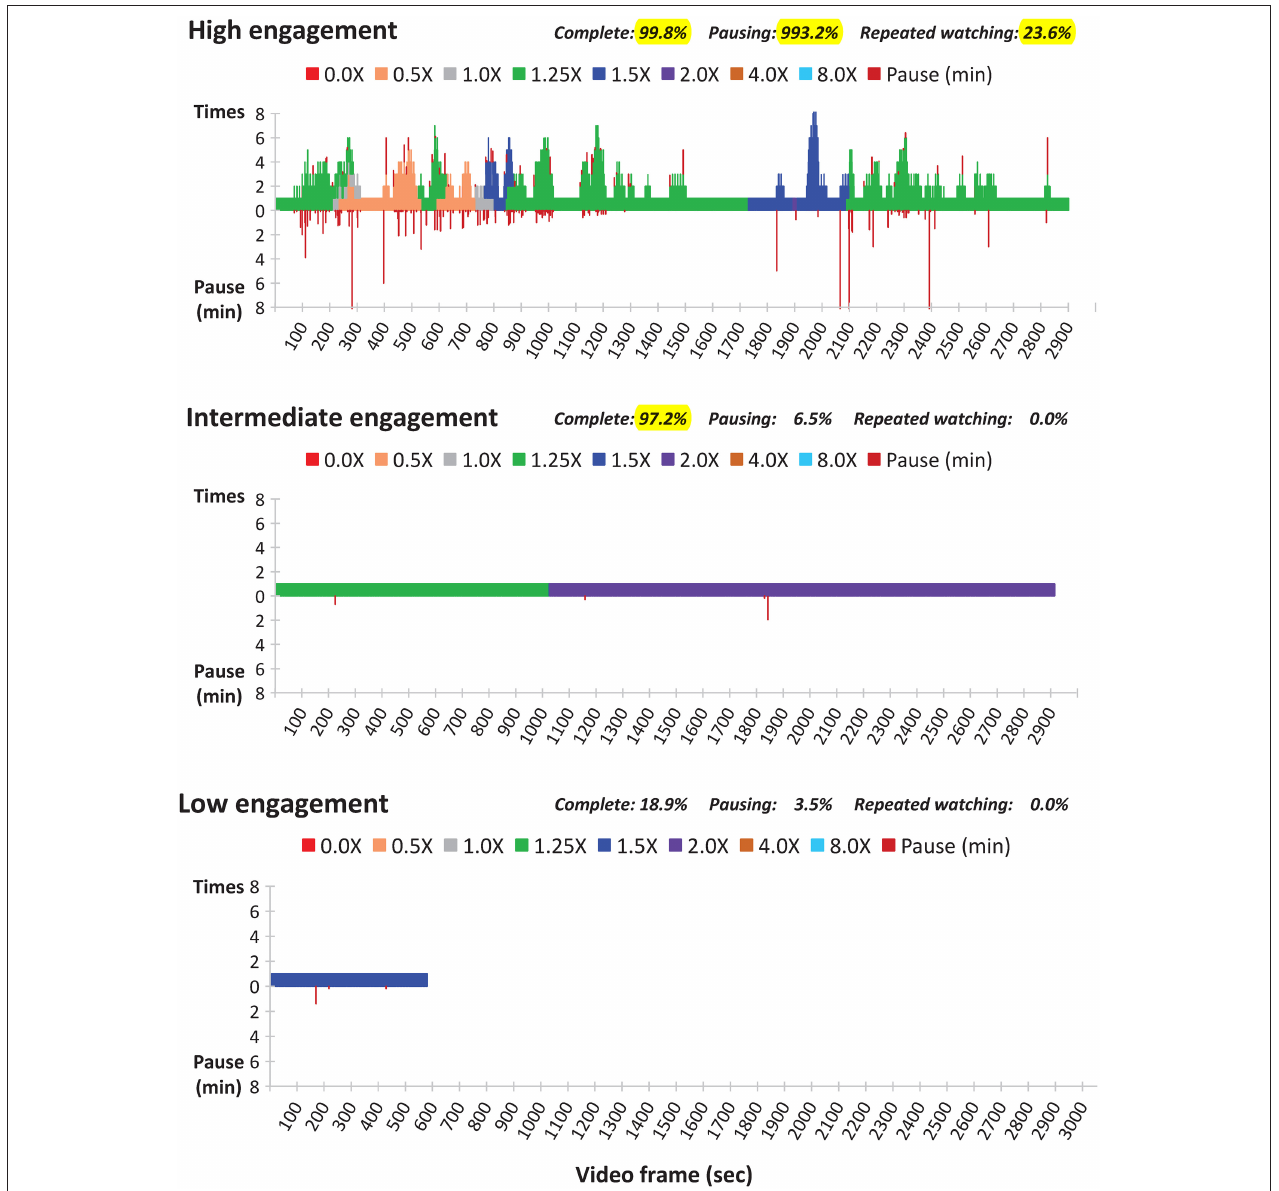
FIGURE 1 | Examples of high engagement (upper panel), intermediate engagement (middle panel) and low engagement (lower panel) with video-based learning (X: play